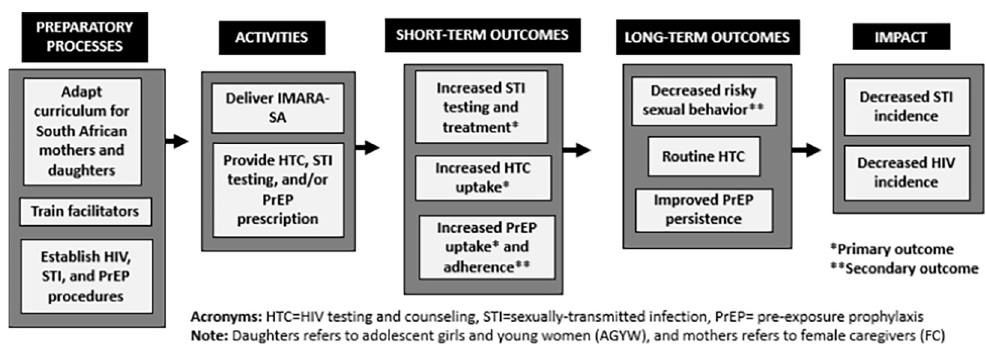
Fig 2. Simplified intervention impact model. Presents how IMARA-SA is expected to lead to the desired impact.